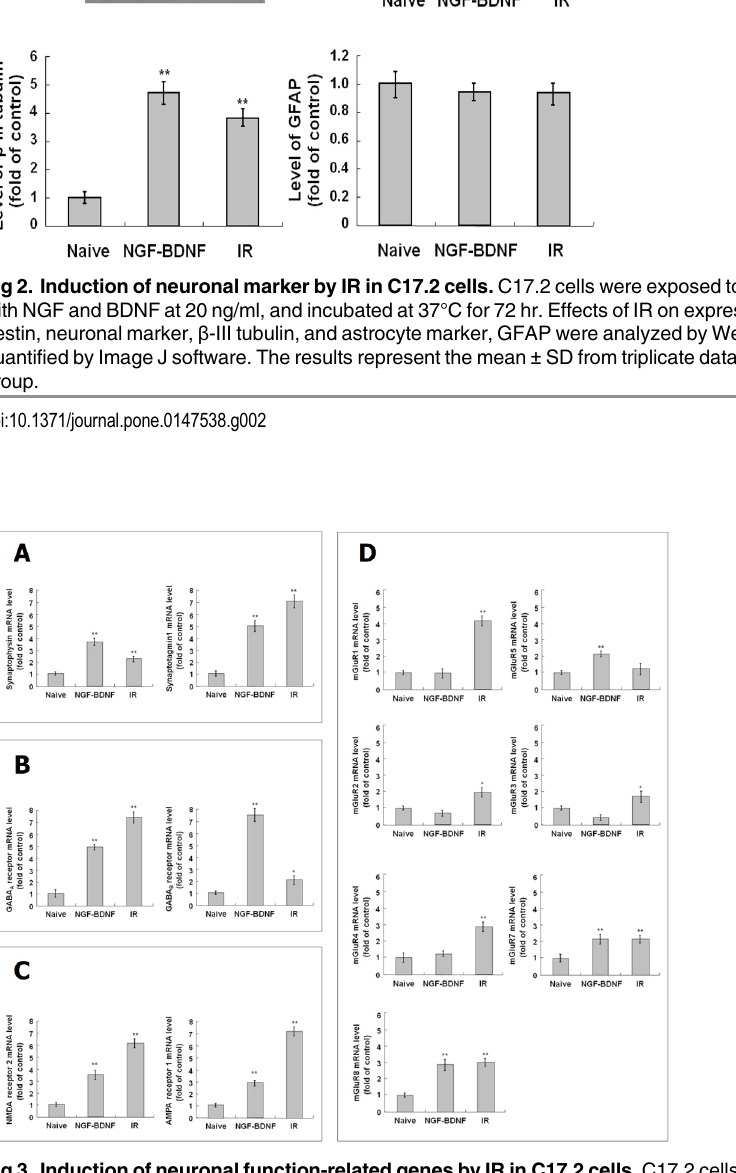
Fig 3. Induction of neuronal function-related genes by IR in C17.2 cells. C17.2 cells were exposed to IR at 6 Gy or treated with NGF and BDNF at 20 ng/ml, and incubated at 37°C for 72 hr. To assess effect of IR on neuronal function-related genes, expression of synaptophysin and synaptotagmin1 (A), GABA A and GABA B receptors (B), ionotropic glutamate receptors (C), and metabotropic glutamate receptors (D) was analyzed by real-time PCR. The results represent the mean ± SD from triplicate data. * p < 0.05, ** p < 0.01 vs naive group.